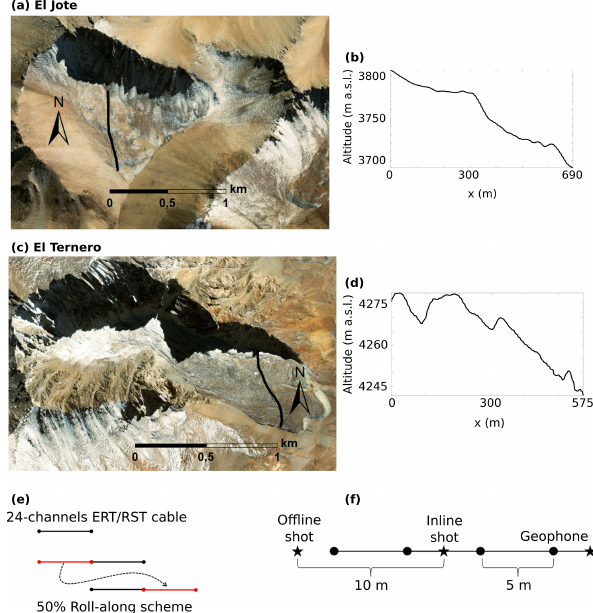
Figure 2. (a) Aerial image of El Jote showing the location of the geophysical survey line and (b) its topography from field differen- tial GPS measurements. (c) Aerial image of El Ternero showing the location of the geophysical survey line and (d) its topography from field differential GPS measurements. Base maps in (a) and (c) from Esri World Imagery (2018). (e) Scheme of the 50% roll-alongs used for ERT surveys on both rock glaciers and RST surveys on El Jote. (f) Scheme of geophones and inline/offline shot positions for RST